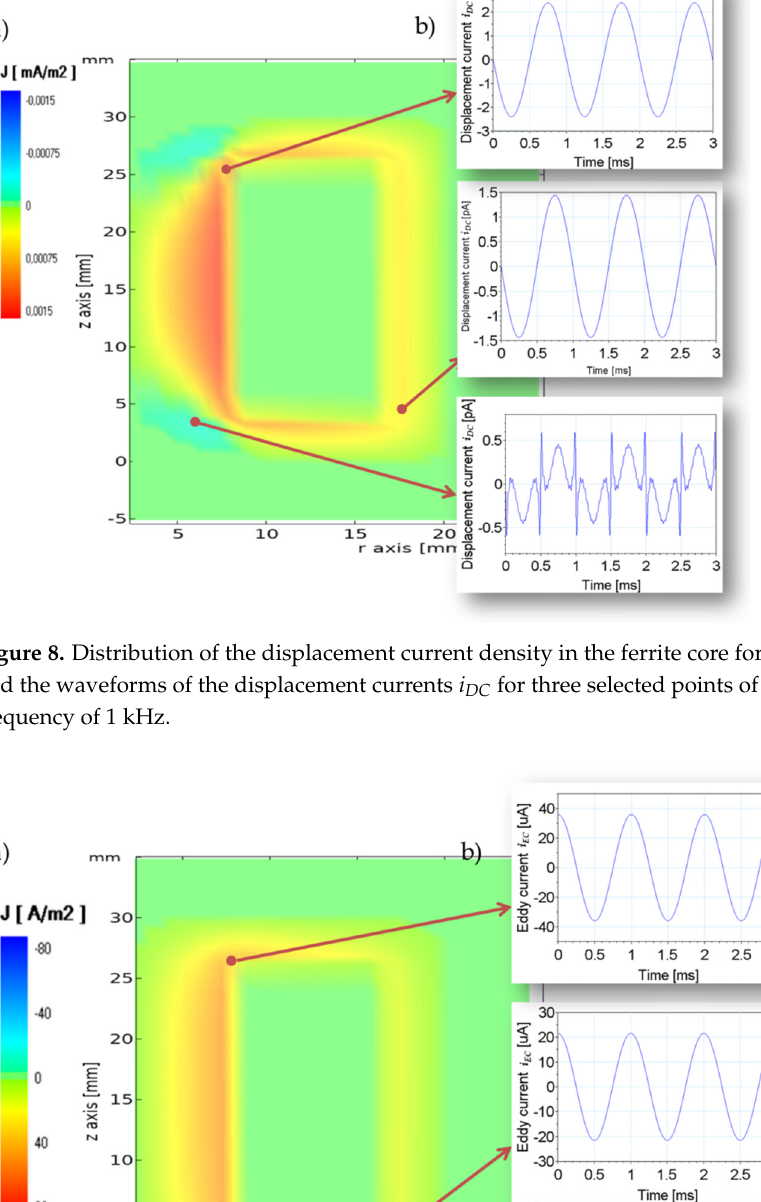
Figure 7. Coil concentrated flux Ψ waveform.